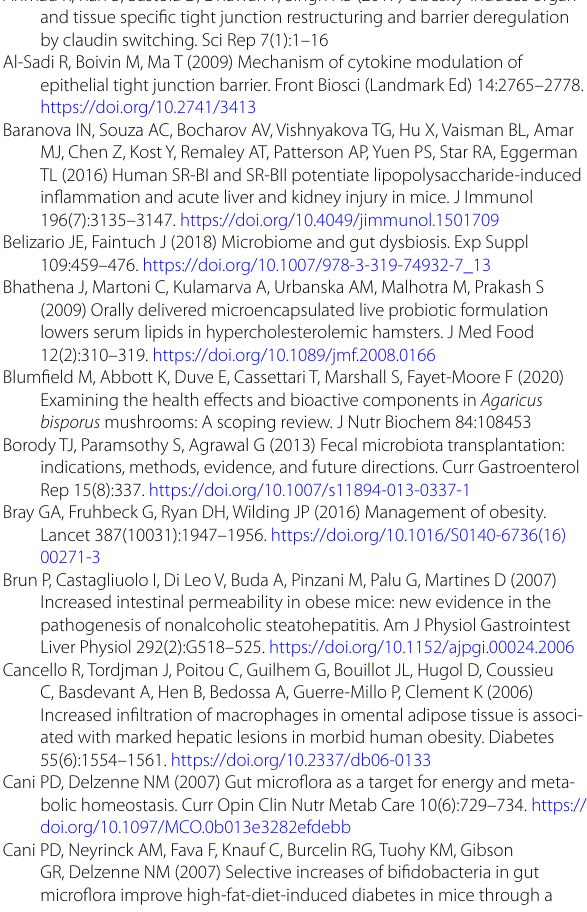
Table S4: Bacterial family percentage in all groups; Fig S1: Analysis of crude polysaccharide from M. esculenta mushroom using high-performance liquid chromatography